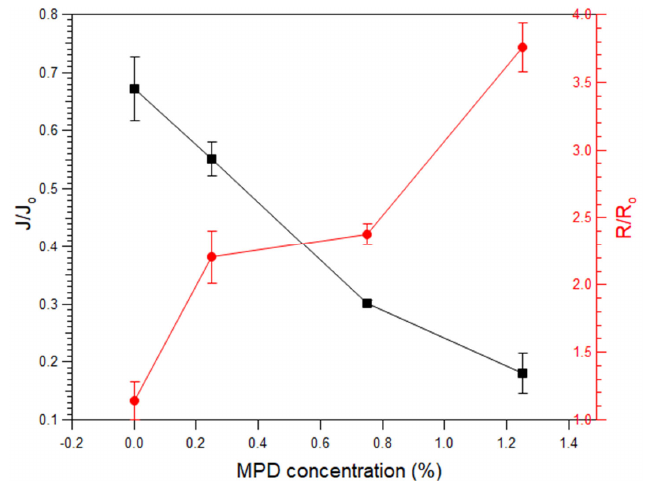
Figure 10. J/J 0 and R/R 0 values of Fenton ‐ MPD ‐ modified membranes.